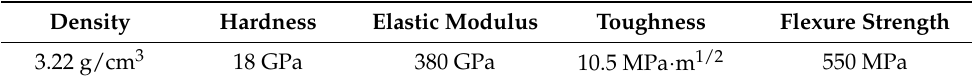
Table 1. The physical properties of Si 3 N 4 . Data from [29].